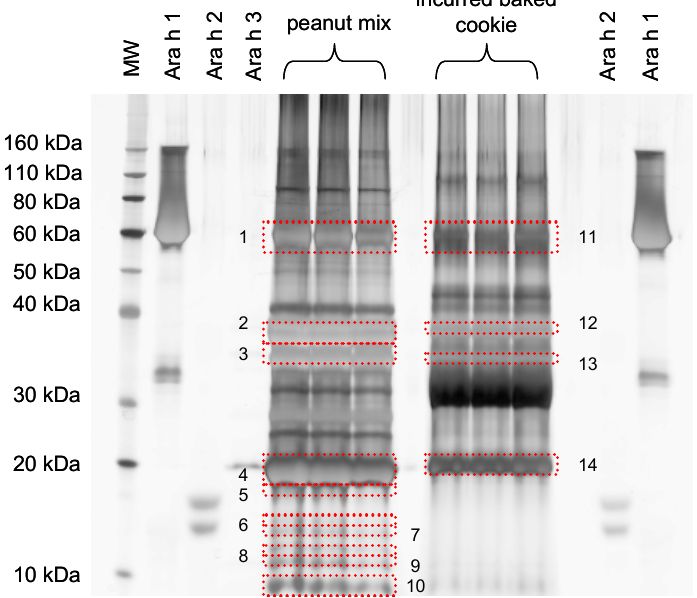
Figure 2. SDS-PAGE protein profiles for IRMM-481f peanut mix and 16 min baked cookie incurred with 100,000 μ g IRMM-481f peanut mix g − 1 matrix. The different band numbers were submitted to trypsin digestion and peptides submitted to nano LC-Q-TOF-MS/MS for protein identification. The list of peptides and identified proteins are presented in Table 3. Five micrograms protein was loaded per lane. A molecular weight standard (MW) of 3.5–260 kDa was run in parallel.